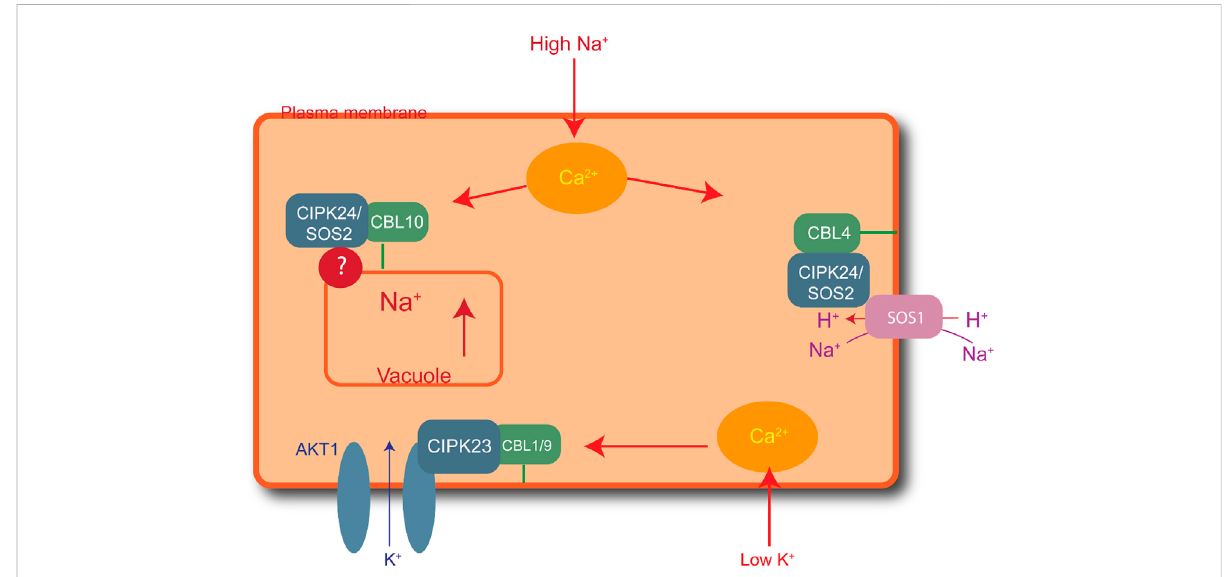
FIGURE 2 Role of CIPK-CBL complexesin managing salt stress in Arabidopsis . CBL4-CIPK24 (SOS2) activates SOS1 for the extracellular transfer of excess